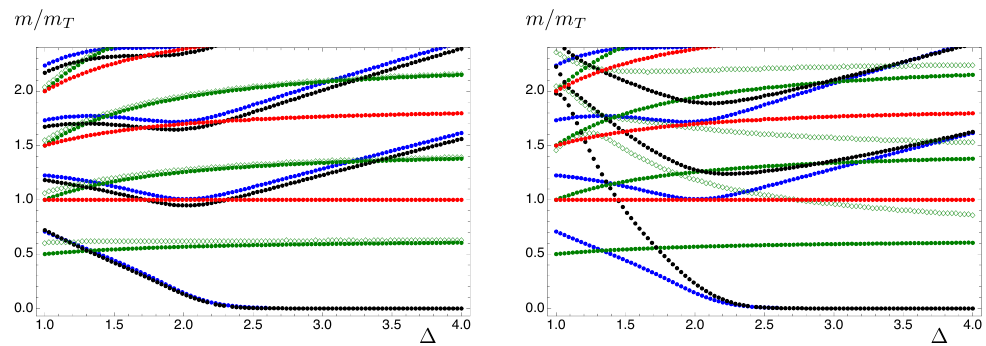
Figure 5 . Example B. Spectrum as a function of ∆ for r 1 = 10 − 4 , r 2 = 8 , and g 5 = 1 (left), g 5 = 5 (right), normalized to the mass m of the lightest tensor. The colour coding is: scalar (blue), tensor T (red), pseudoscalar (black), vector (green), axial-vector (green diamonds).